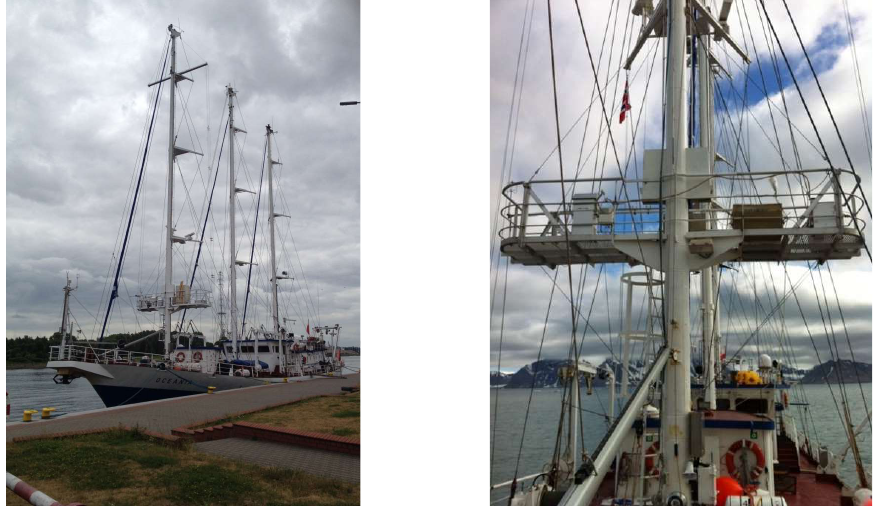
Figure 1. Research vessel Oceania ( left ) and location of the total suspended particulate (TSP) sampler on the balcony ( right ) of the Oceania.